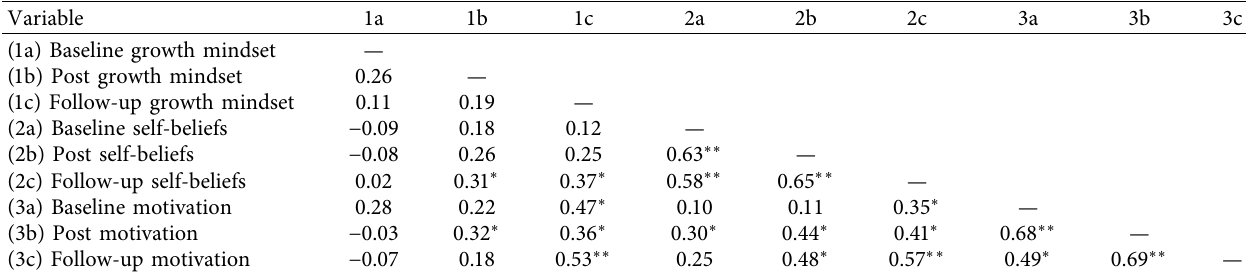
Table 7: Correlations between the dependent variables.